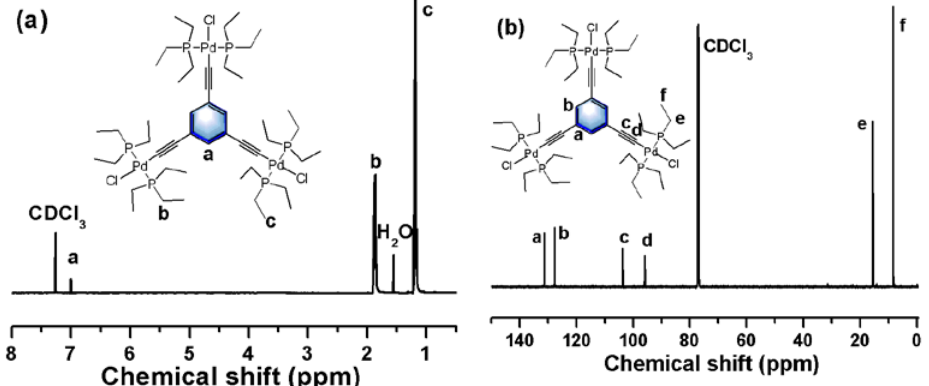
Figure 3. ( a ) 1 H NMR and ( b ) 13 C NMR spectra of palladium catalyst.